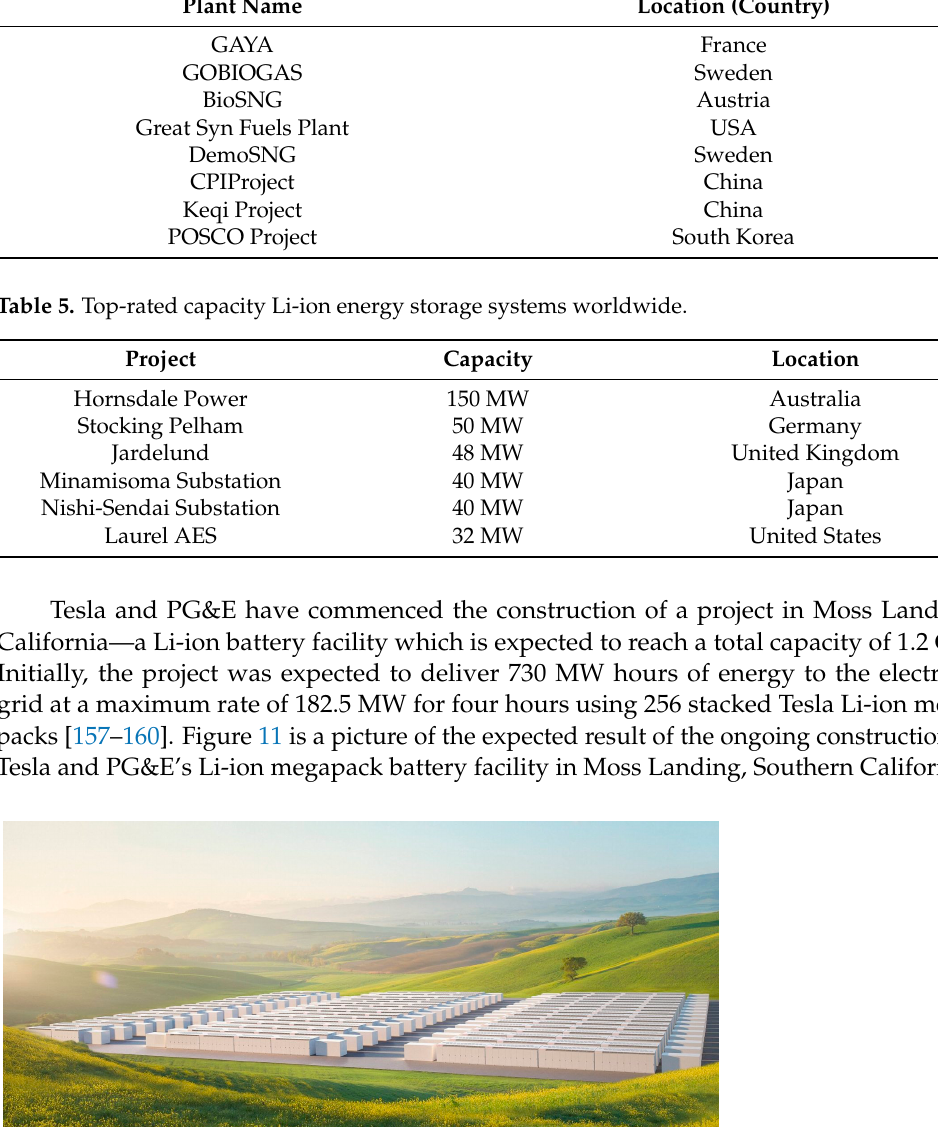
Table 4. Top methane-producing plant names against their location. Plant Name